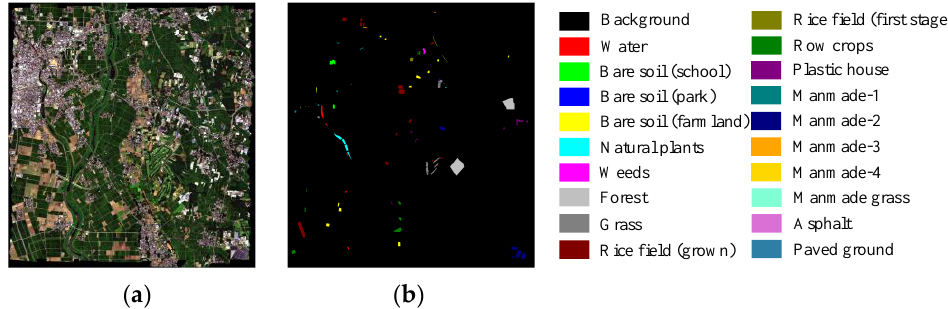
Figure 9. Chikusei dataset: ( a ) false color map, ( b ) ground truth. Table 4. Land cover classes and numbers of samples in the Chikusei dataset. Table 3. Land cover classes and numbers of samples in the Houston dataset.